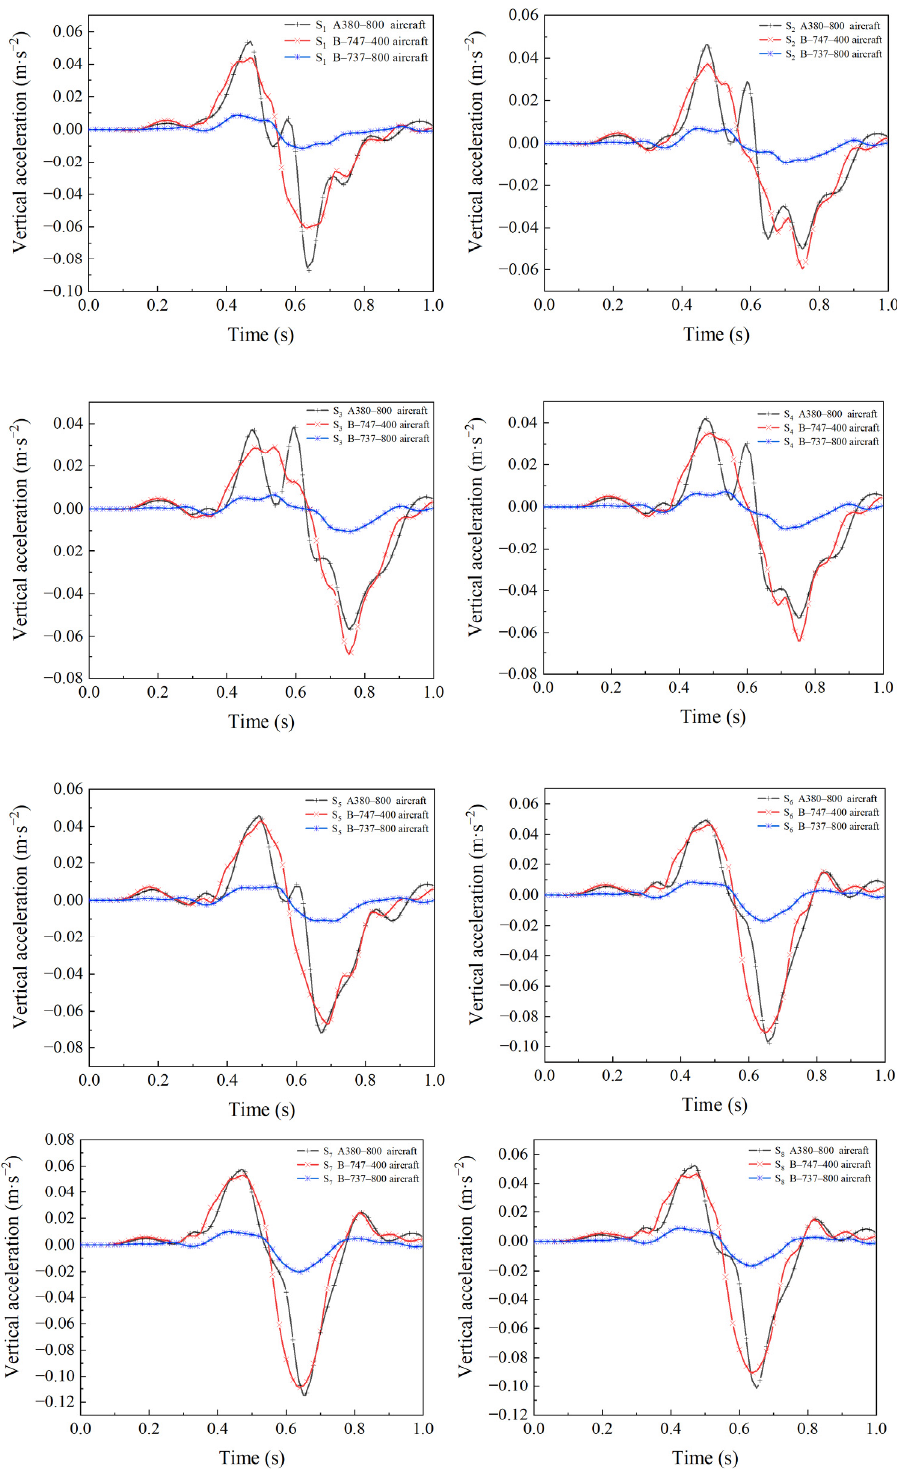
Figure 10. Vertical acceleration-time curves of monitoring points under different aircraft types.